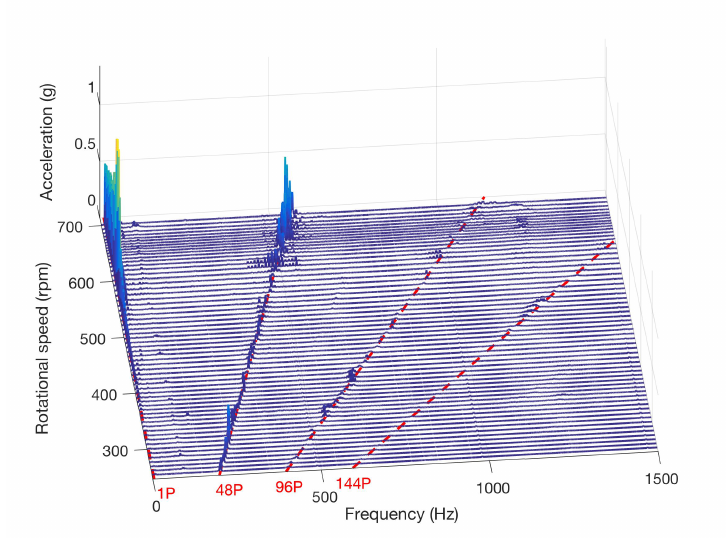
Figure 7. Waterfall of Y direction tower vibrations from wind tunnel measurements.